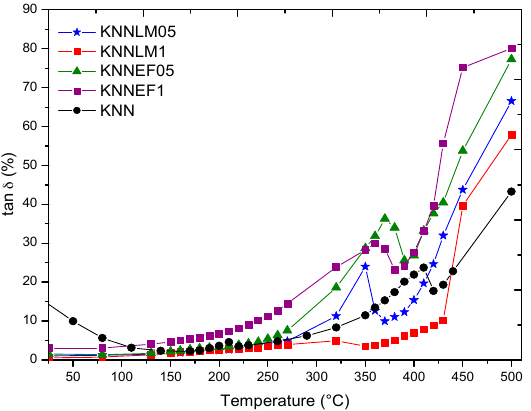
Figure 10. Dielectric loss tangent vs. temperature of KNN and its solid solutions, measured at 10 kHz. Table 4. Piezoelectric, elastic and dielectric coefficients including all losses and other relevant parameters at the radial resonance of a thin disk, thickness poled, and measured at the d 33 -meter of KNN and its solid solutions.